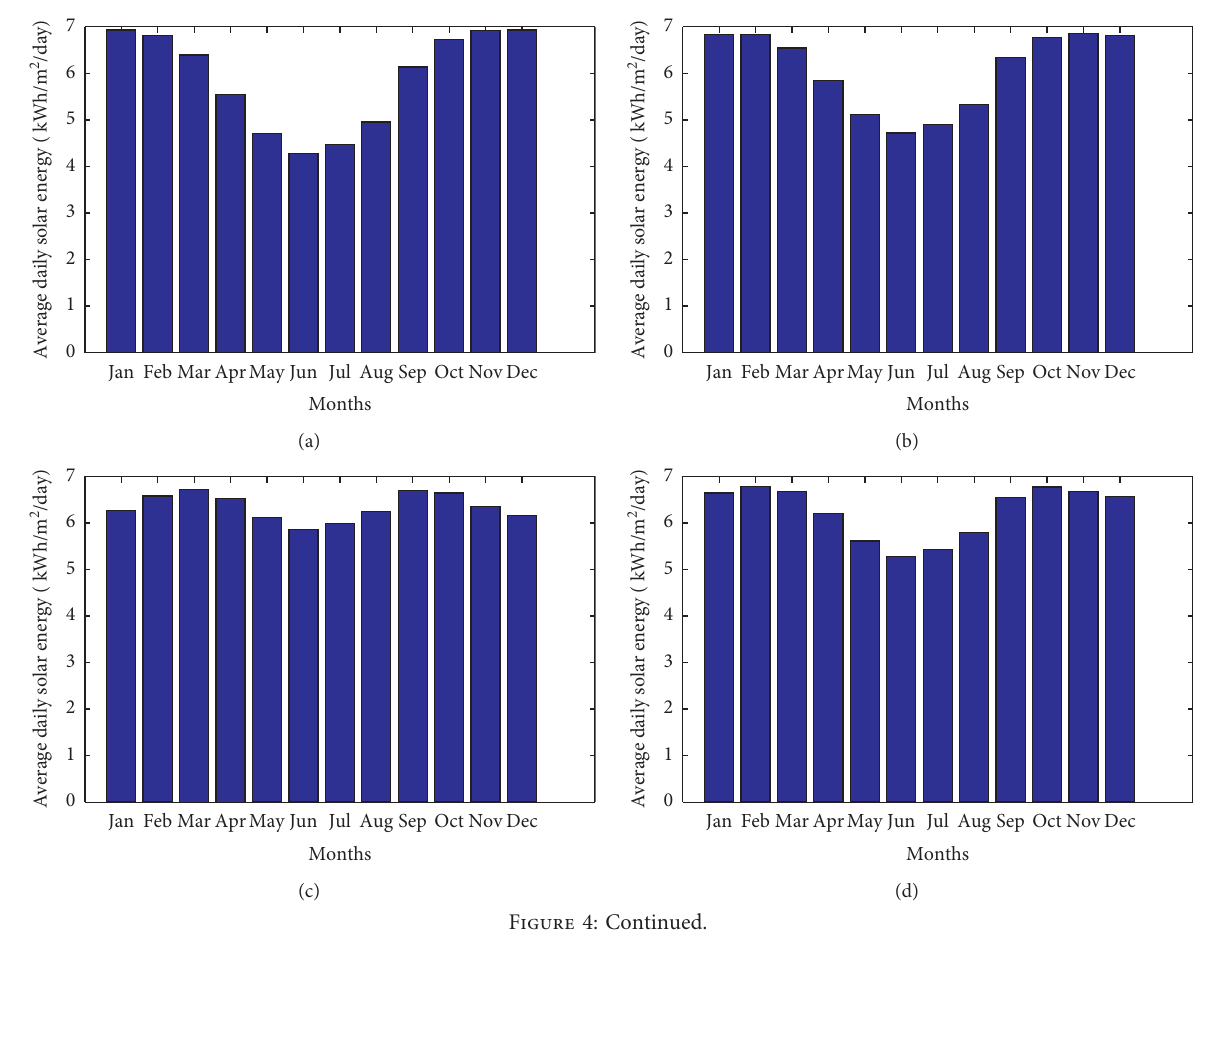
Figure 3: PV energy outputs at monthly optimized angles: January to June: (a) PV energy output at λ energy output at λ Mar ; (d) PV energy output at λ Apr ; (e) PV energy output at λ May ; (f) PV energy output at λ Jun